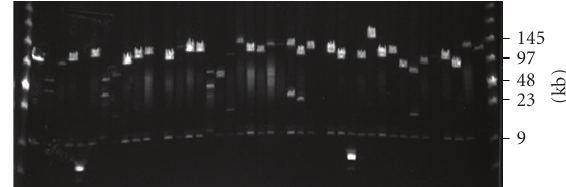
Figure 2: Insert size determination of orangutan BAC library clones. DNA from 92 random BAC clones was isolated, digested with NotI and separated using pulse field gel electrophoresis (PFGE) on two gels. Low Range PFG marker (NEB) was loaded in the flanking wells. A subset of the analyzed BACs from a single gel is shown. Forty-one recombinant clones and 2 noninsert clones can be seen. The band comigrating in all clones with the 9-Kb marker band is the BAC vector.